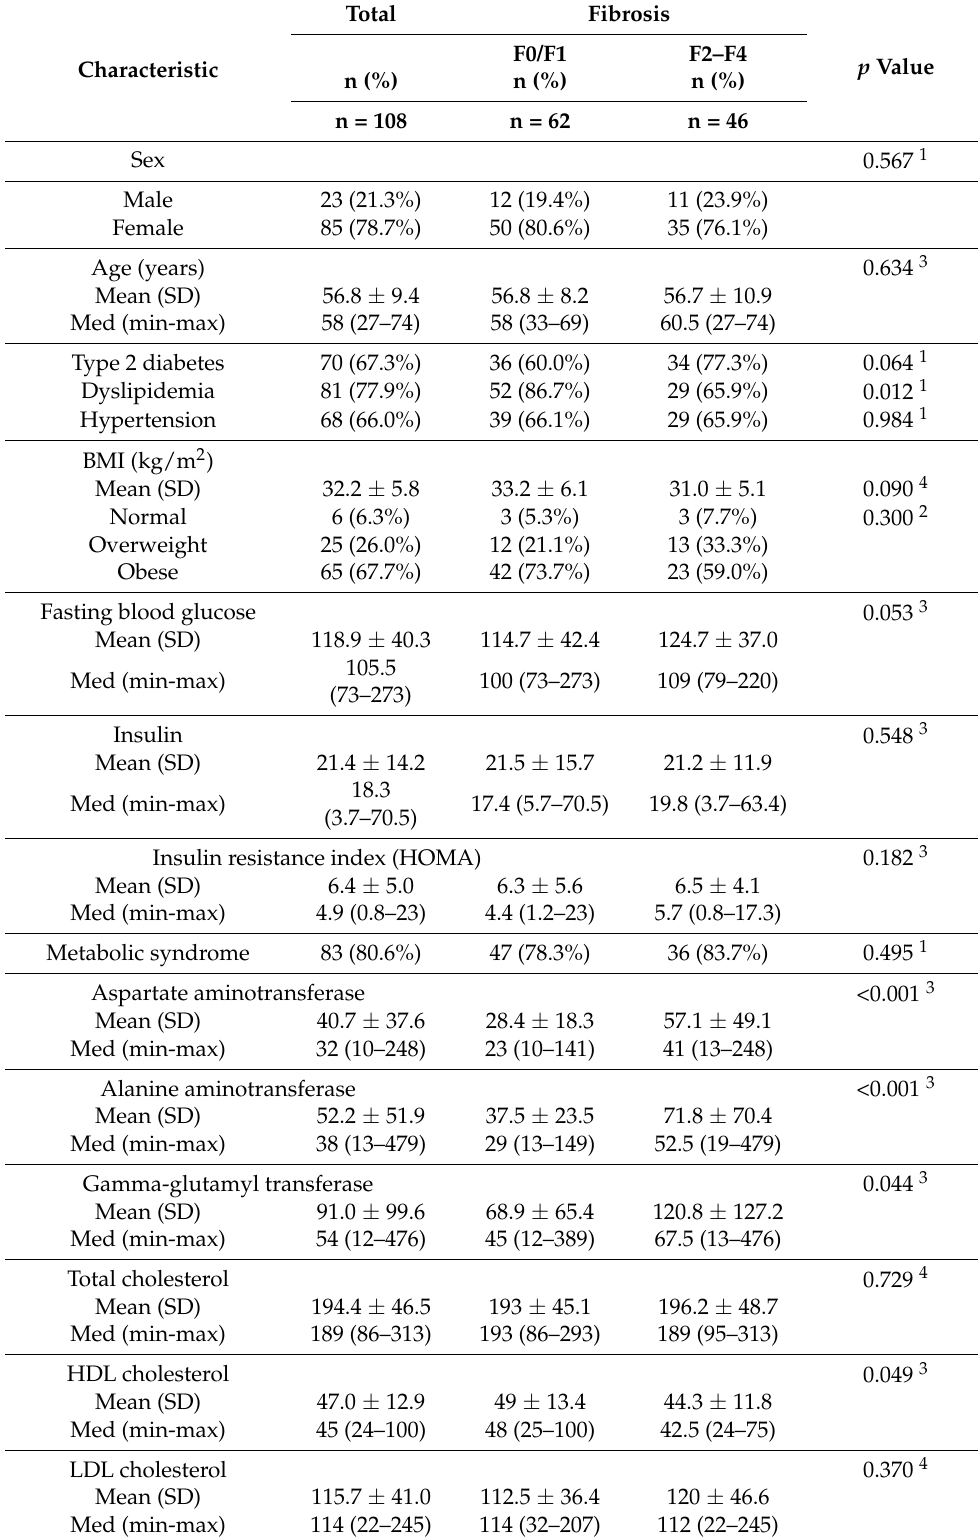
Table 1. Characteristics of patients according to the degree of